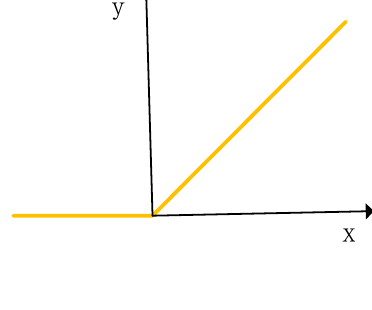
Figure 6. Rectified Linear